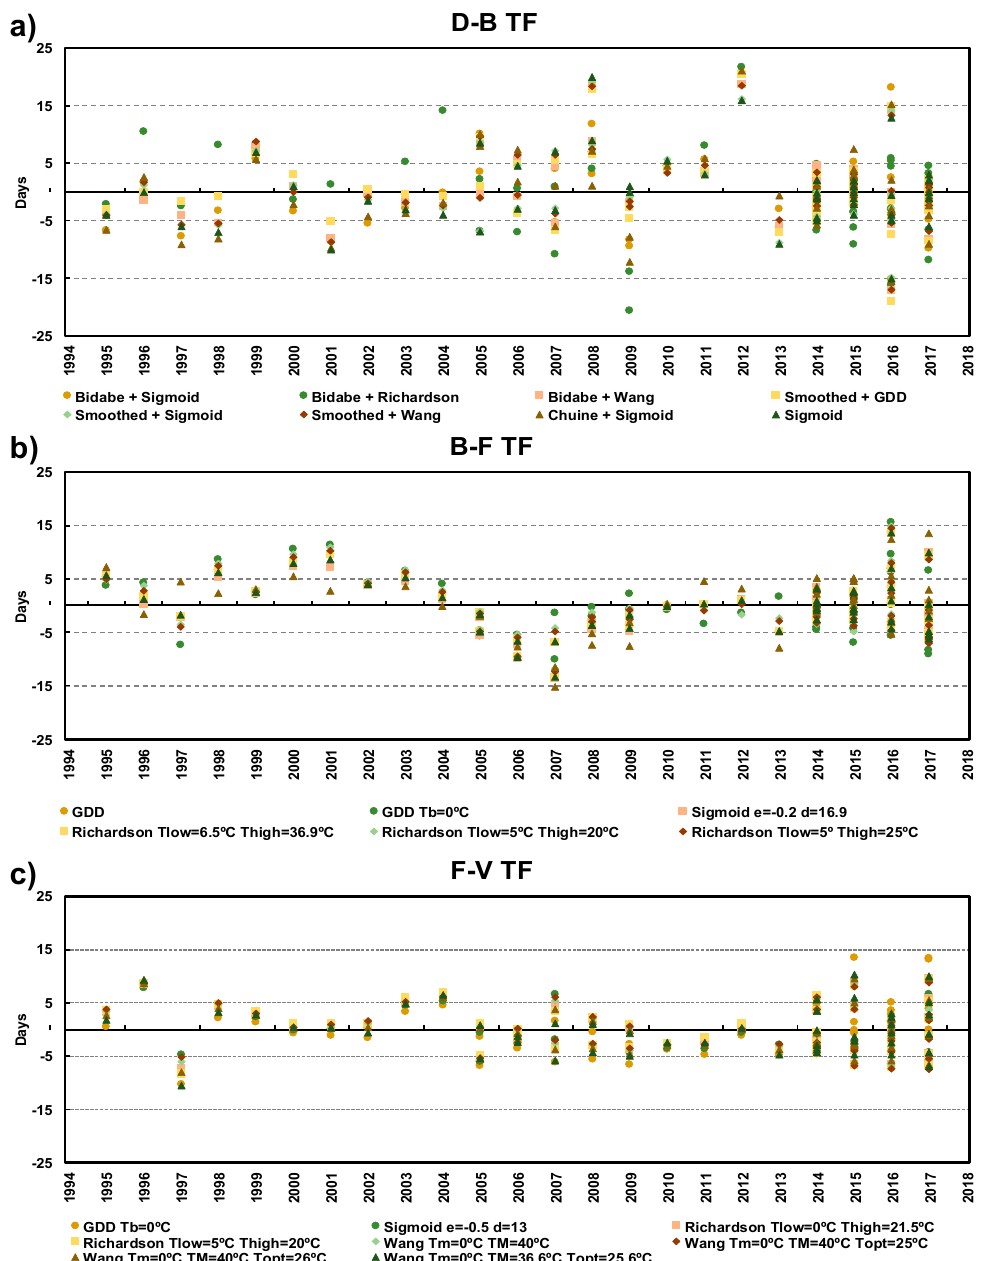
Figure 2. Chronograms of the departures between simulated and observed phenological timings of each phenophase on cv. Touriga Franca : ( a ) Dormancy–Budburst (D-B); ( b ) Budburst–Flowering (B-F), and ( c ) Flowering–Veraison (F-V), obtained from the eight selected models (cf. legends) and assembled for the 14 vineyard sites (Figure 1).